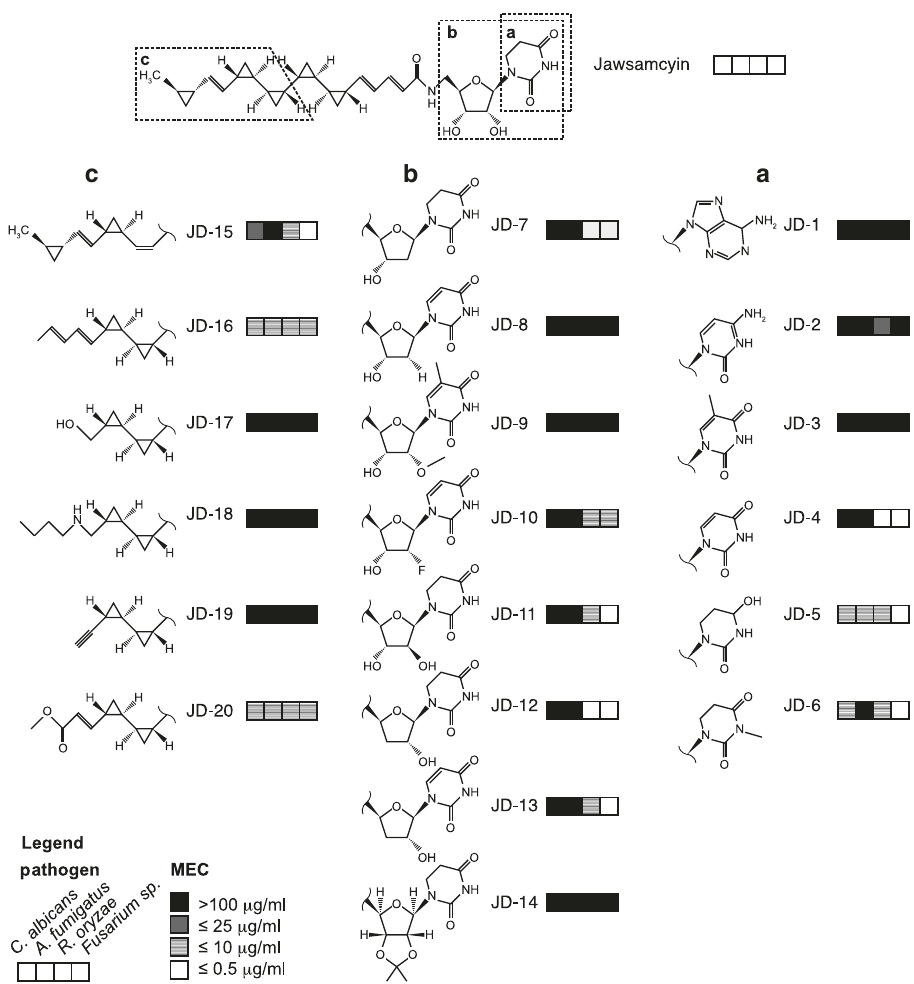
Fig. 4 Chemical derivatization and bioactivity pro fi ling of jawsamycin. Chemical variation of the dihydro uracil moiety ( a -series) the dihydro uridine moiety ( b -series) and the cyclopropylated fatty acid tail moiety ( c -series) was undertaken with the natural compound as starting material. The obtained jawsamycin derivatives (numbered JD-X) were puri fi ed, structure veri fi ed and tested against the indicated four different fungal pathogens to obtain minimal effective concentrations